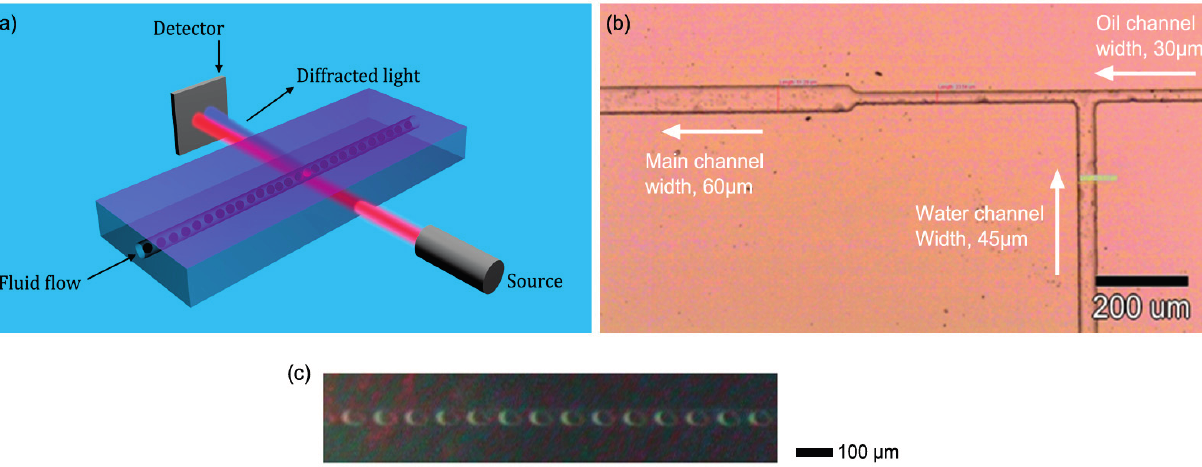
Figure 1. ( a ) Schematic illustration of the optofluidic flow rate sensing device, comprising of microfluidic channels, light source and detector; ( b ) A micrograph showing the fabricated T- junction section in PDMS; ( c ) Photographs showing the periodic bubble array in the